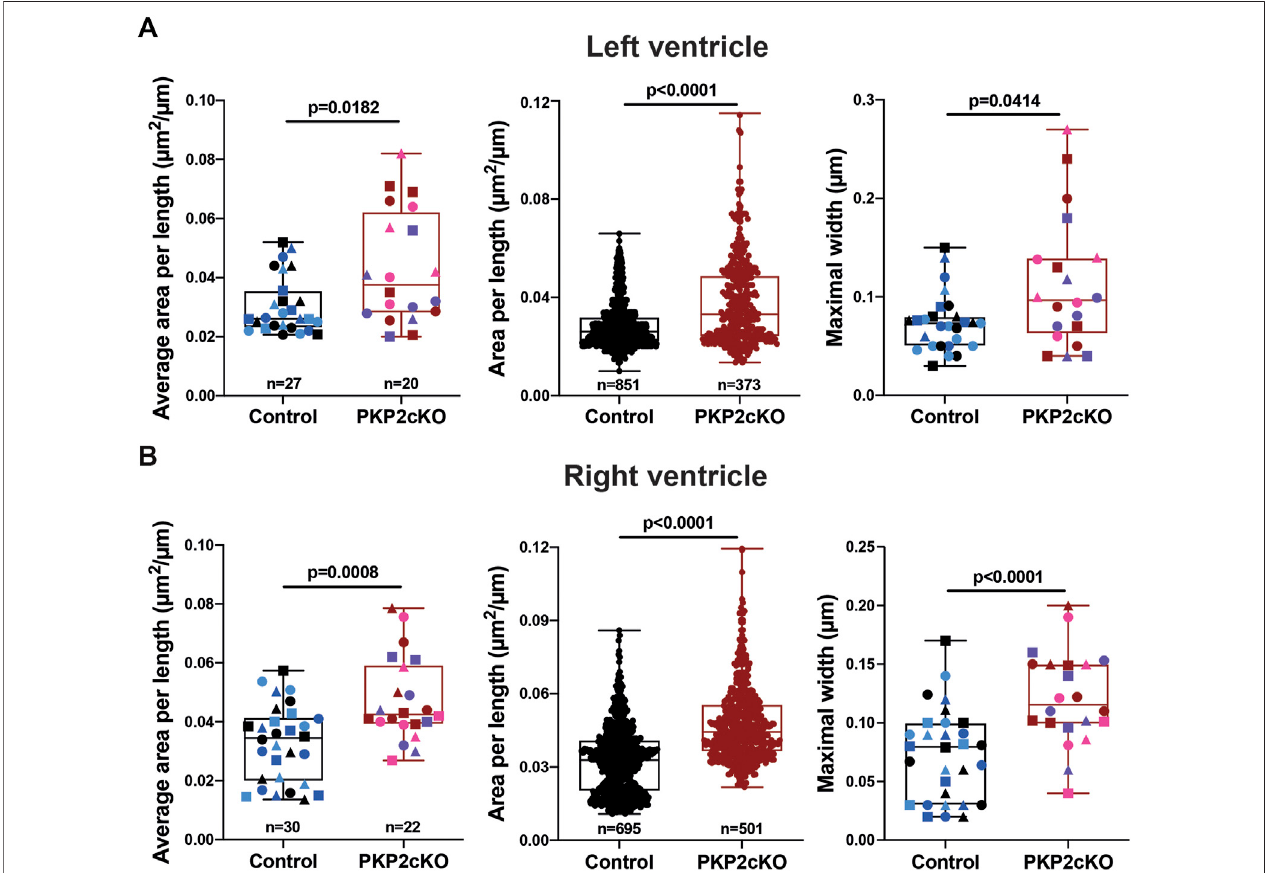
FIGURE 4 | Gap junction plaque separation in left and right ventricular samples of Plakophilin2 conditional knock out hearts (PKP2cKO). (A) Quanti fi cation of 2D surface between intercalated disc (ID) membranes in left ventricular samples of control and PKP2cKO hearts, corrected for ID length (Area per length), averaged per ID ( left panel ) and per individual section ( middle panel ). Right panel : Maximal width between ID membranes, per ID. Left and right panel : Control; n = 27, PKP2cKO; n = 20. Middle panel: Control; n = 851, PKP2cKO; n = 373. Data presented as box and whisker (min. – max.) plot. Colors depict data points corresponding to different animals. Shapes depict data points corresponding to differenct regions of interest. Signi fi cance as per Mann-Whitney test. (B) Quanti fi cation of 2D surface between intercalated disc (ID) membranes in right ventricular samples of both groups, corrected for ID length (Area per length), averaged per ID ( left panel ) and per individual section ( middle panel ). Right panel : Maximal width between ID membranes, per ID. Left and right panel : Control; n = 30, PKP2cKO; n = 22. Middle panel : Control; n = 695, PKP2cKO; n = 501. Data presented as box and whisker (min. – max.) plot. Colors depict data points corresponding to different animals. Shapes depict data points corresponding to different regions of interest. Signi fi cance in left and middle panel as per Mann-Whitney test, right panel as per Student ’ s t -test.